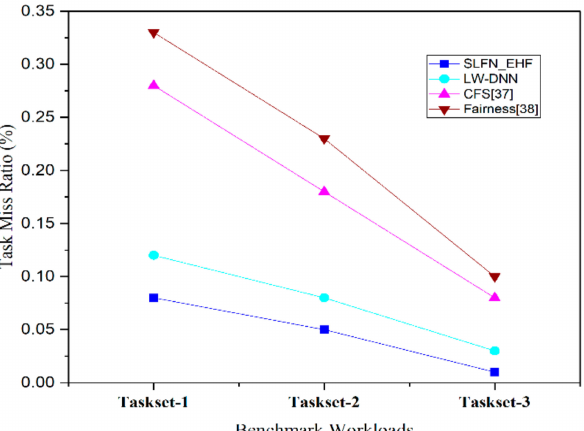
Figure 10. Normalized Task Miss Ratio observed for Benchmark workloads on Hardware Configura- tion 1.